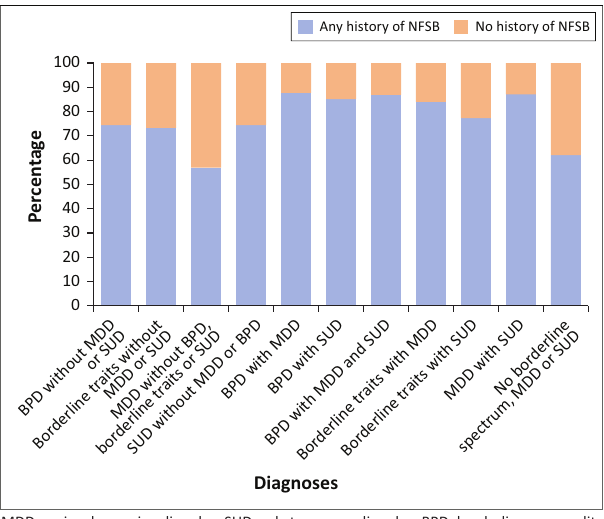
FIGURE 1: Percentage of patients with a positive and negative history of non- fatal suicidal behaviours according to diagnosis and